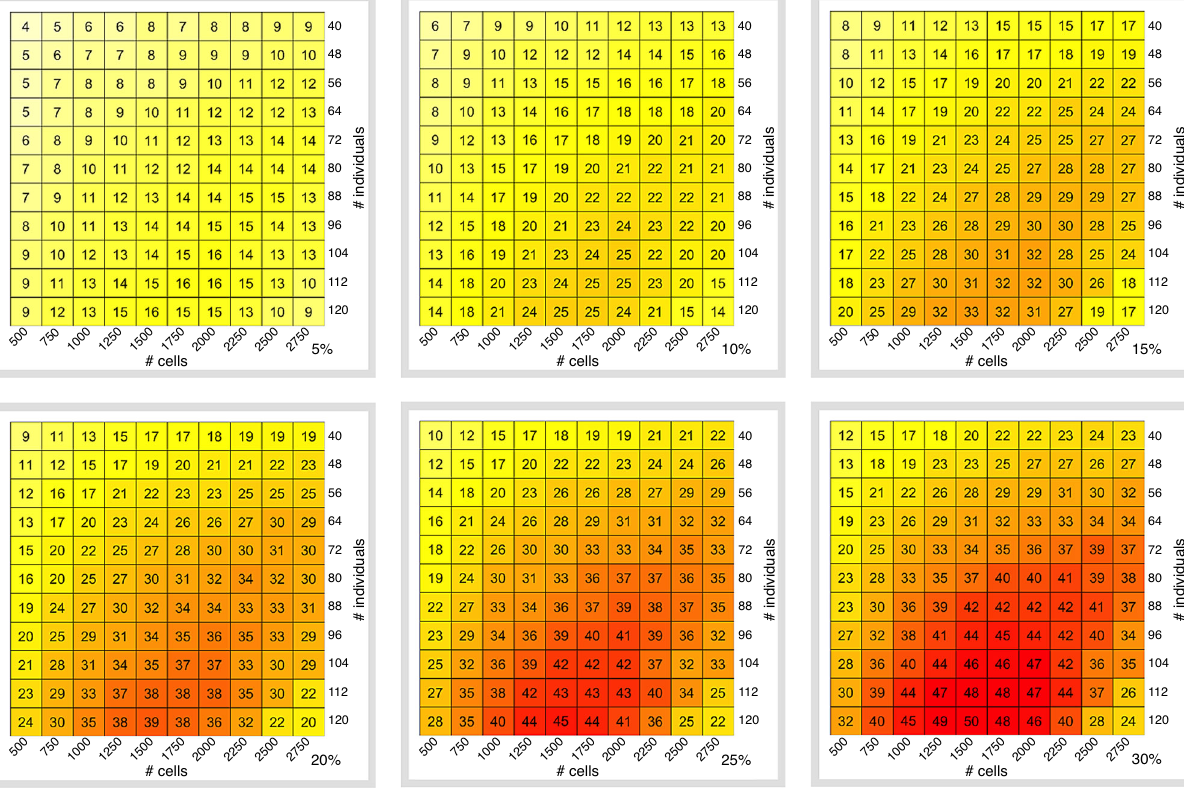
Cell-type eQTL power analysis in empirical data . For the budget B = $35,000, we performed ct-eQTL analyses for each experi- mental design ( N , M , r ), where N ranged from 40 to 120 with step 8 and M ranged from 500 to 2750 with step 250. We also ran the ct-eQTL analysis on the original dataset to obtain the